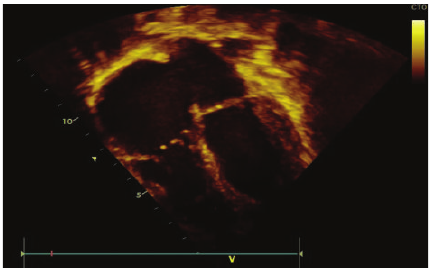
Figure 3: Tricuspid valve vegetation on septal tricuspid valve leaflet.